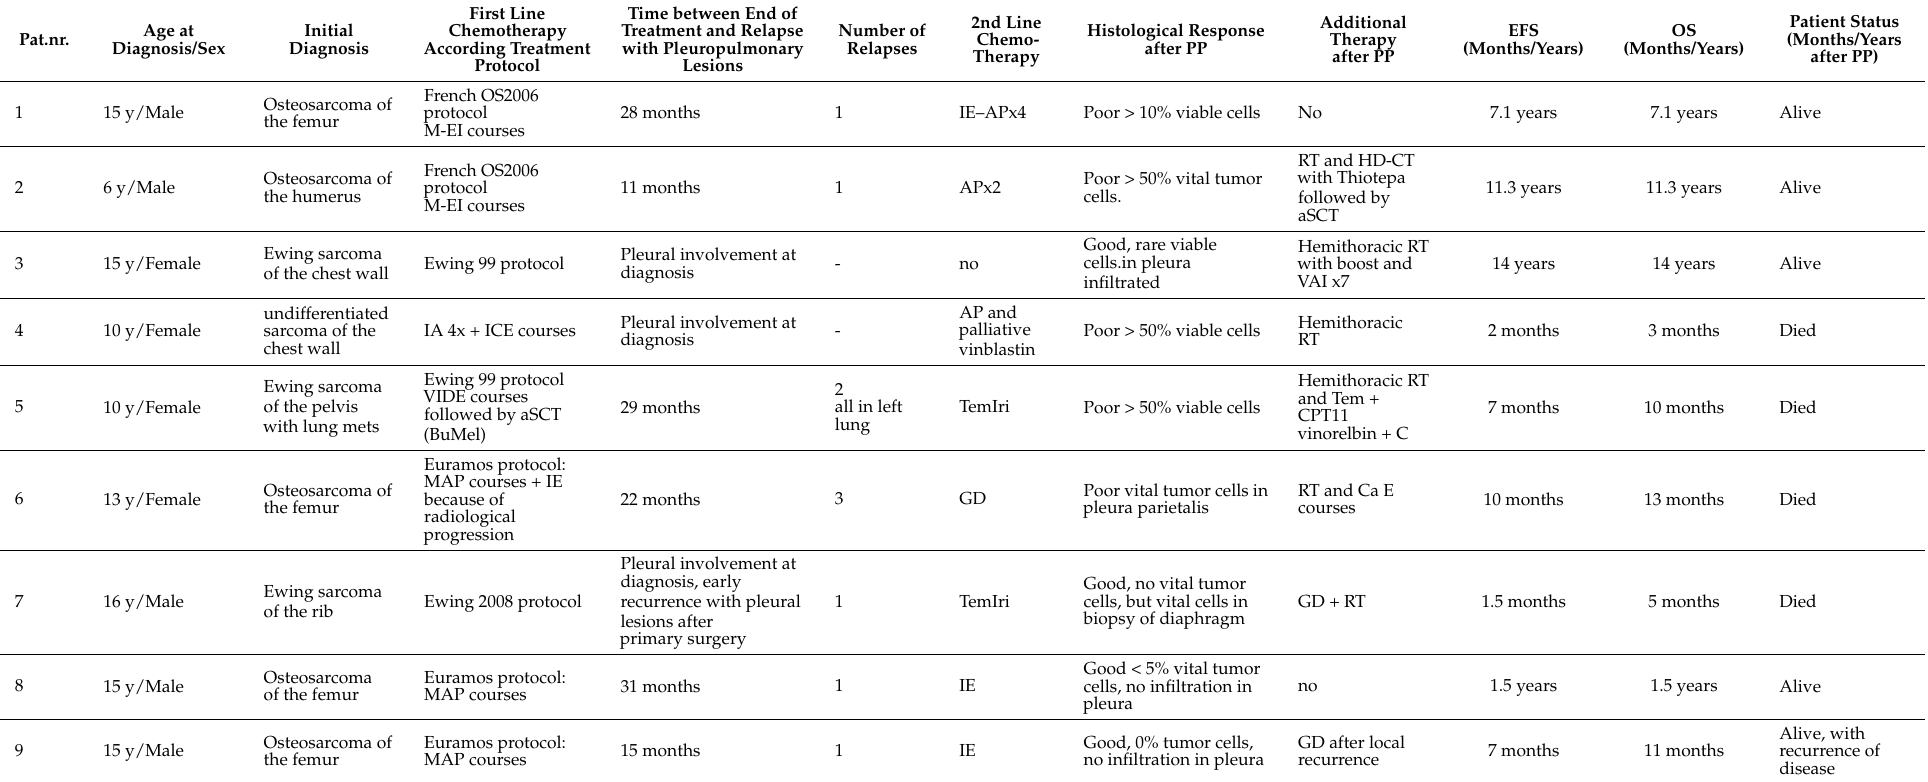
Table 1. Patient characteristics who underwent total pleuropneumonectomy (PP) for pleuropulmonary localization of a sarcoma and non-surgical treatment. M = Methotrexate, E = etoposide, I = ifosfamide, A = adriamycin, P = cisplatin, G = gemcitabin, D = docetaxel, Tem = temozolomide, Iri = irinotecan, C = cyclophosphamide, Ca = carboplatin, RT = radiotherapy, HD-CT high-dose chemotherapy, aSCT = autologous stem cell transplantation, BuMel = busulphan, melphalan, EFS = event-free survival, OS = overall survival.